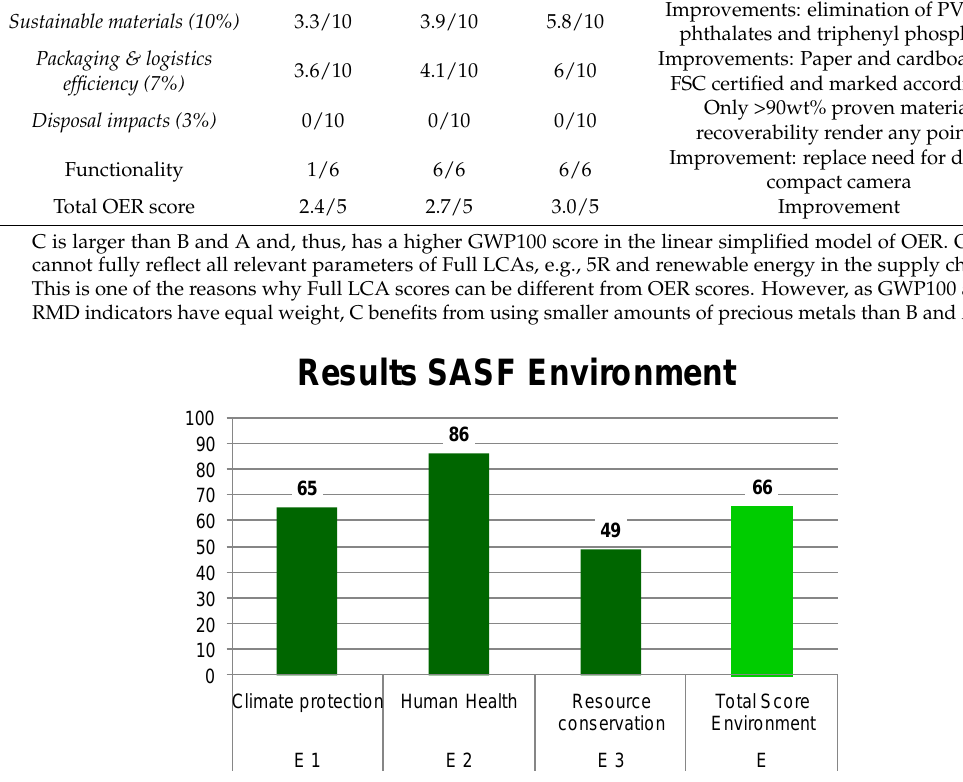
Figure 3. Huawei mobile devices SASF Total Score Environmental as sum of climate protection, human health, and resource conservation scores.